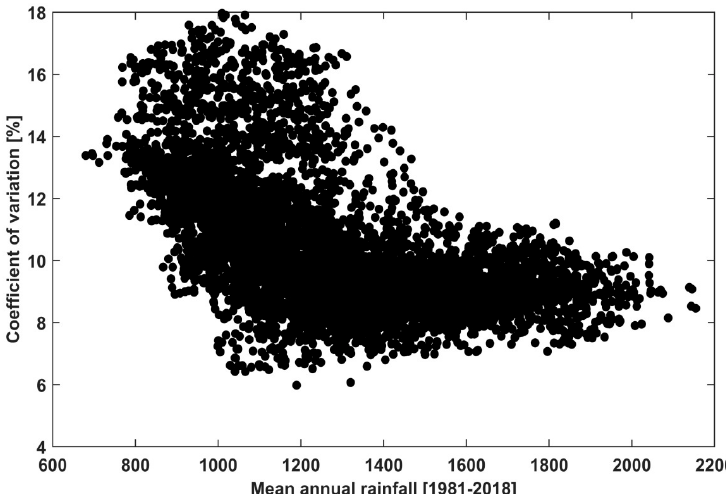
Figure A2. The relationship between the coefficients of variation (%) and long-term mean annual rainfall (mm). The CV increases with a decrease in mean annual rainfall with the coefficient of correlation (r) equal to − 0.57.